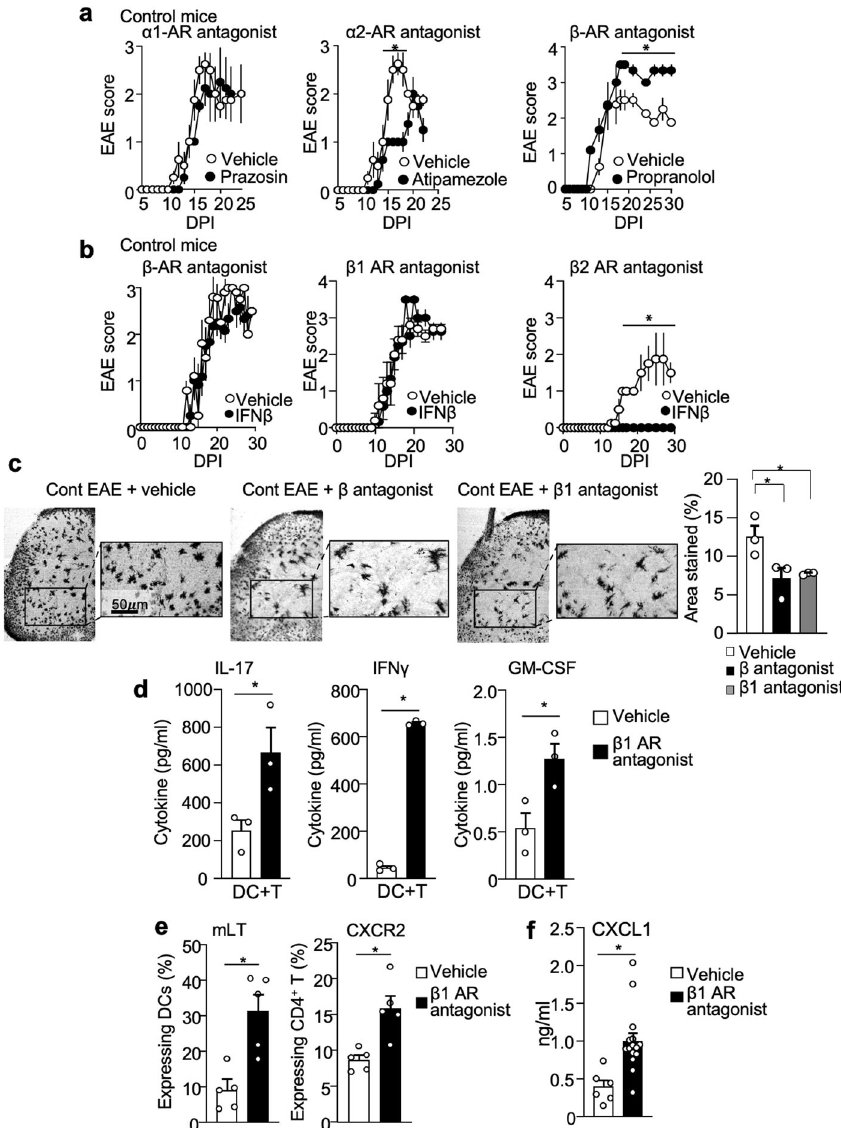
Fig. 7 β 1 adrenergic receptor antagonism is suf fi cient to reproduce the ELT-induced EAE phenotypes. a EAE scores of control mice with intraperitoneal injections of α 1-AR antagonist (prazosin, 5 mg/kg), α 2-AR antagonist (atipamezole, 5 mg/kg), or β -AR antagonist (propranolol, 5 mg/kg) with vehicle control ( n = 4 animals/group). All drugs were treated from 0 to 10 dpi every other day. b EAE scores of IFN β -treated control EAE mice subjected to β -AR antagonist (propranolol, 5 mg/kg), β 1-AR antagonist (metoprolol tartrate, 5 mg/kg), β 2-AR antagonist (ICI 118,55, 1 mg/kg), or vehicle treatment ( β -AR antagonist-Veh: n = 5, β -AR antagonist-IFN β : n = 5, β 1-AR antagonist-Veh: n = 5, β 1-AR antagonist-IFN β : n = 6, β 2-AR antagonist-Veh: n = 4, β 2-AR antagonist-IFN β : n = 4). c Representative images stained quanti fi cation of Golgi – Cox staining in the ventral lumbar spinal cord region of vehicle-treated and β 1-AR antagonist-treated control EAE mice at 30 dpi. Quanti fi cation of area stained by Golgi – Cox ( n = 3 animals/group). d Amount of cytokines IL-17, interferon γ (IFN γ ), and GM-CSF in supernatant derived from culture conditions 72 h post culture initiation. CD4 + T cells were isolated from draining lymph nodes of control EAE mice and mice subjected to β 1-AR antagonist ( n = 3 animals/group). e Percentages of mLT-expressing lymph node DCs and CXCR2- expressing CD4 + T cells from EAE mice with β 1-AR antagonist or vehicle treatment ( n = 5 animals/group). f Serum levels of CXCL1 at 10 dpi ( n = 4 animals/group). Male mice were used for experiments. Each dot represents averaged data per animal. Data are represented as mean ± SEM. Student ’ s t - test, * P < 0.05. Exact P values for asterisks (from left to right): a 0.0004; b <0.0001; c 0.0498; 0.0318; d 0.0462, <0.0001, 0.0322; e 0.0032, 0.0048; f